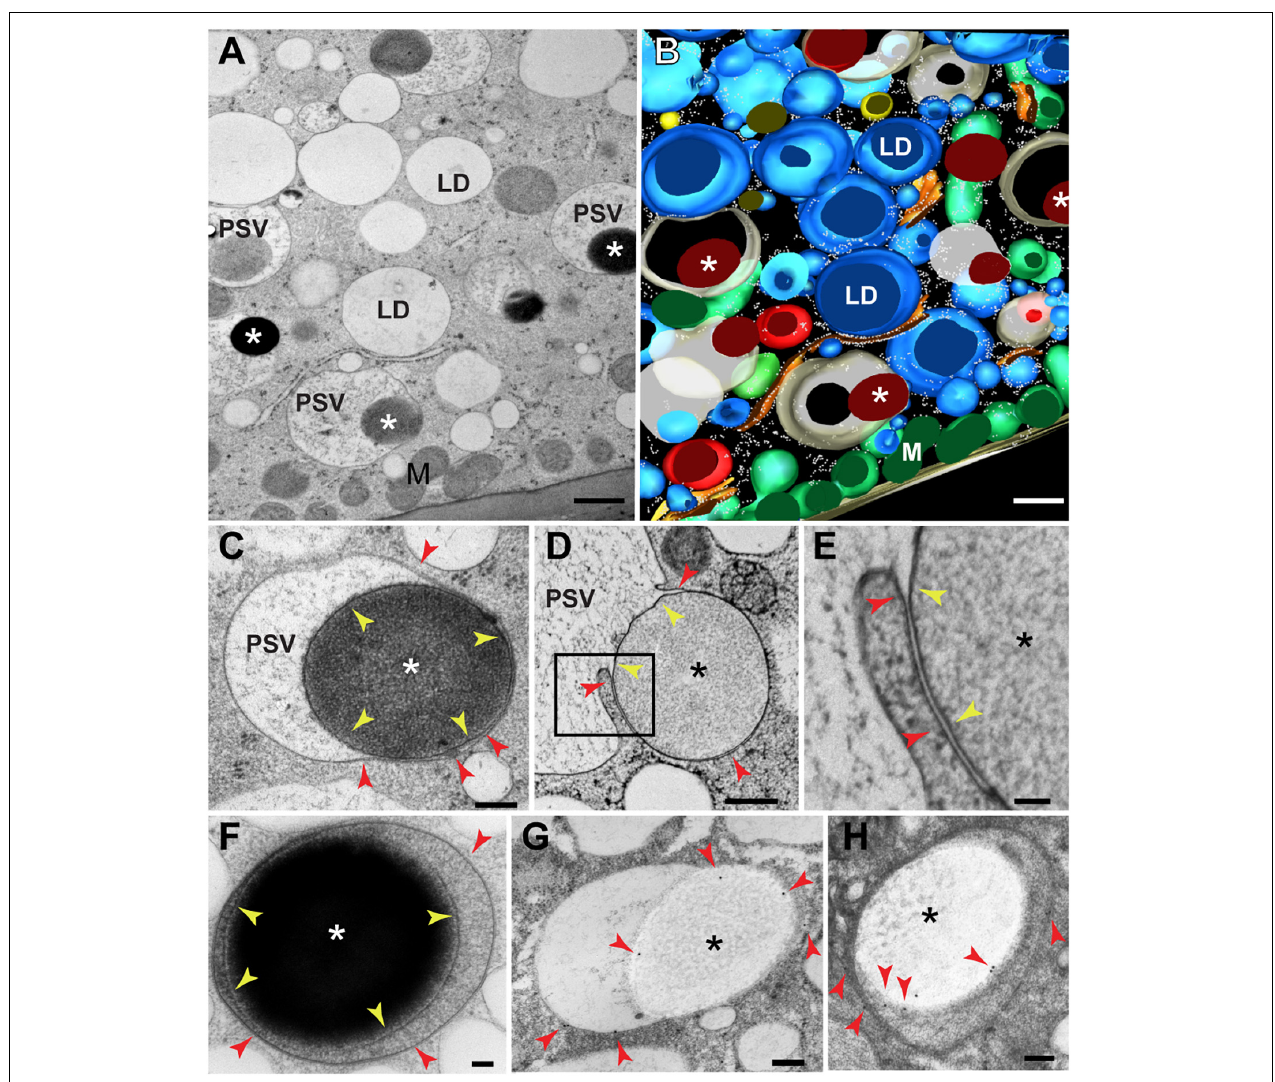
FIGURE 1 | Transmission electron microscopy of protein storage vacuoles (PSVs) in maize aleurone cells. (A) Individual serial section and (B) 3D reconstruction resulting from 8 serial sections (70 nm thick) of wild type (W22) maize aleurone cells at 20 DAP. Note the presence of large electron-dense inclusions (asterisks) inside vacuoles. (C) Detail of a developing vacuoles with a protein storage inclusion (asterisk) surrounded by a membrane (yellow arrowheads). The vacuolar membrane or tonoplast is indicated by red arrowheads. (D,E) Another example of a vacuole at 24 DAP engulfing a protein storage inclusion (asterisk). The membrane domain surrounding the inclusion is indicated by yellow arrowheads and the membrane domain continuous with the rest of the tonoplast, with red arrowheads. (F) Aleurone vacuoles at 26 DAP containing a storage protein inclusion (I) surrounded by a membrane (yellow arrowheads). (G,H) Immunolabeling with antibodies against a tonoplast-resident H + -pyrophosphatase revealed that the membrane domain surrounding the inclusion derives from the tonoplast. Red arrowheads indicate gold particles. LD, lipid droplet; M, mitochondrion. Scale bar = 800 nm in (A,B) ; 500 nm in (D) ; 200 nm in (C,G,H) ; 100 nm in (E,F)